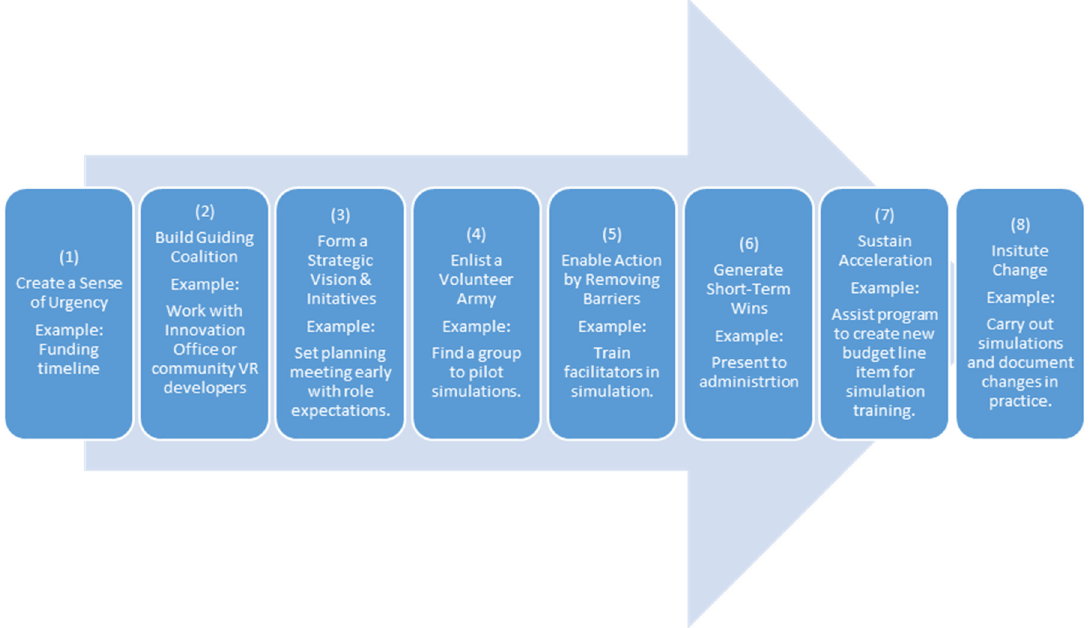
Figure 1. Kotter’s steps applied to crossing the power line to implement simulation training with a diverse workforce.